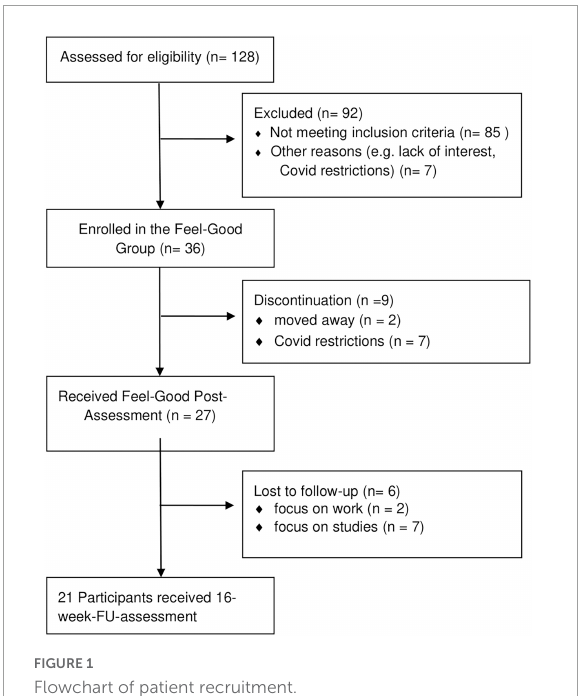
FIGURE1 Flowchart of patient